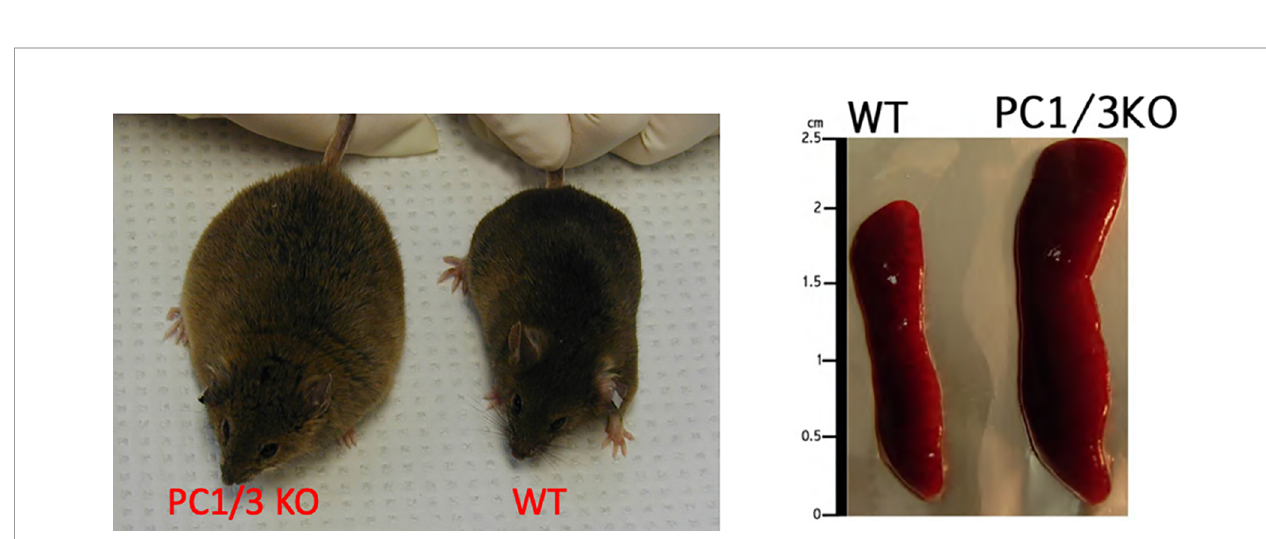
FIGURE 2 | Comparison of PC1/3 KO mice phenotype with WT and the size of their spleen.